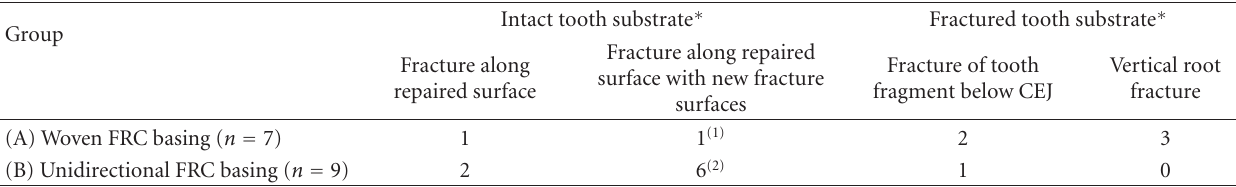
Table 3: Condition of the repaired specimens after the load